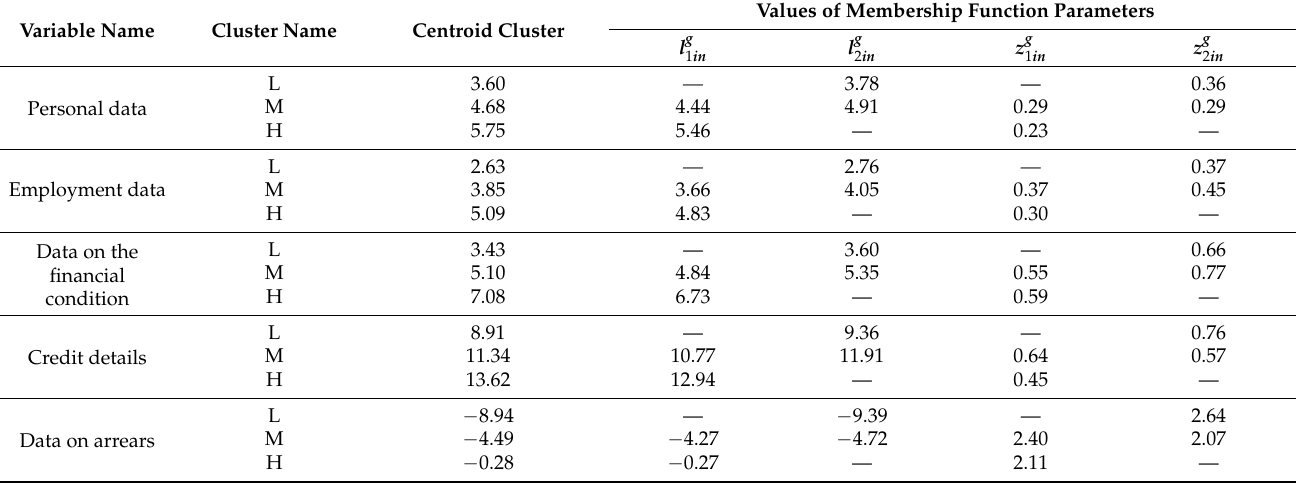
Table 2. Parameters of clusters and parameters of membership functions of intermediate integral indicators based on the results of their neural